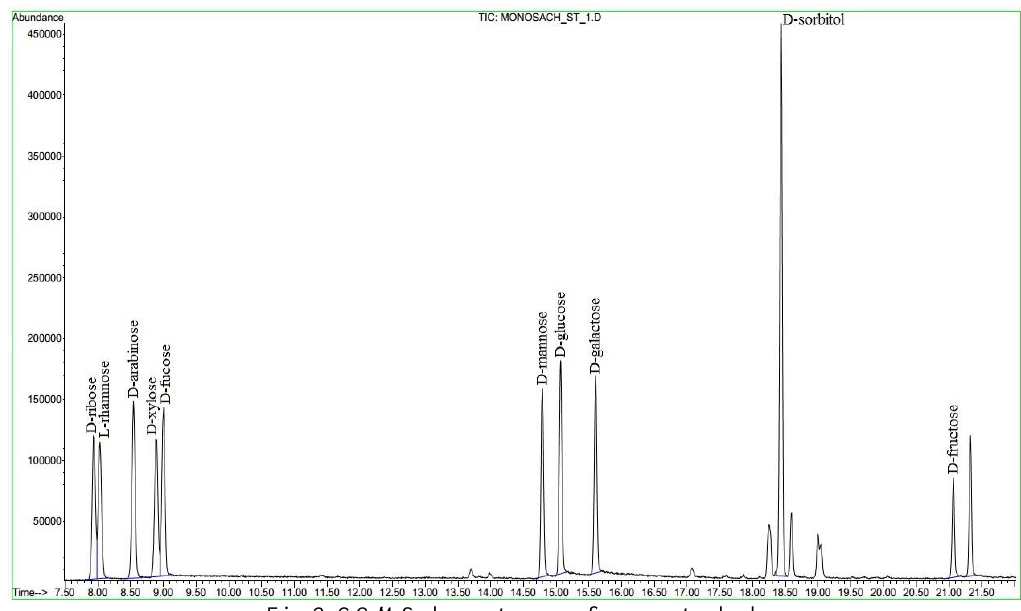
Fig. 2. GC/MS chromatogram of sugars